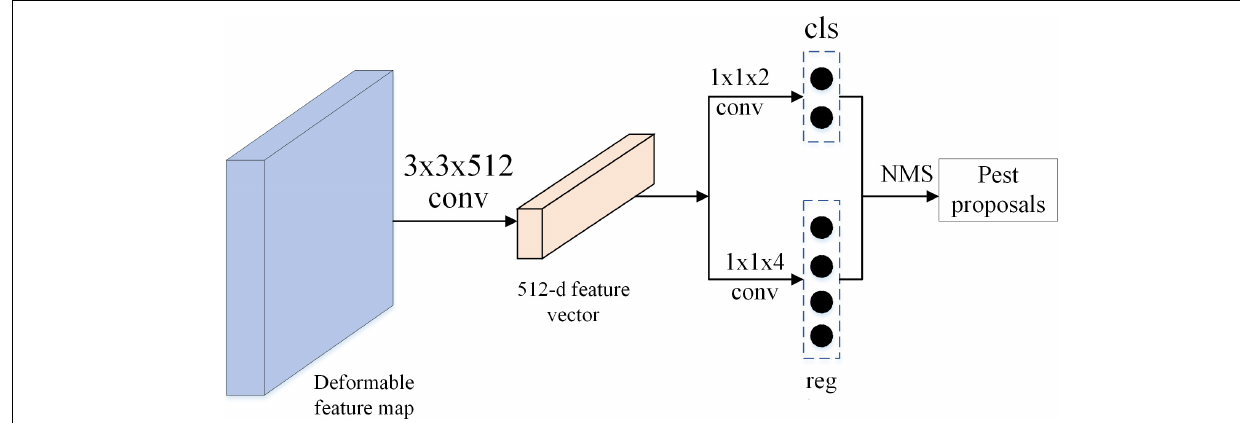
FIGURE 5 | Network structure of pest region proposal generation module.